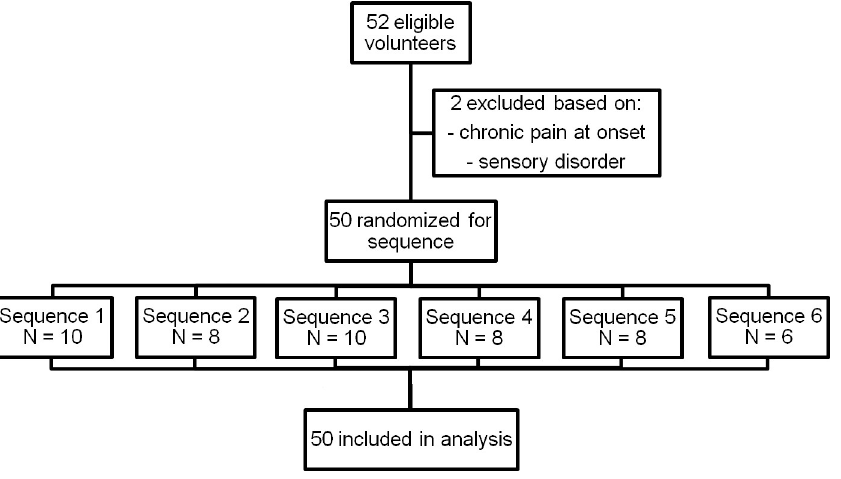
Fig 2. Flow diagram of participants (Conditions: C = control, P = Passive Virtual Reality, A = Active Virtual Reality).